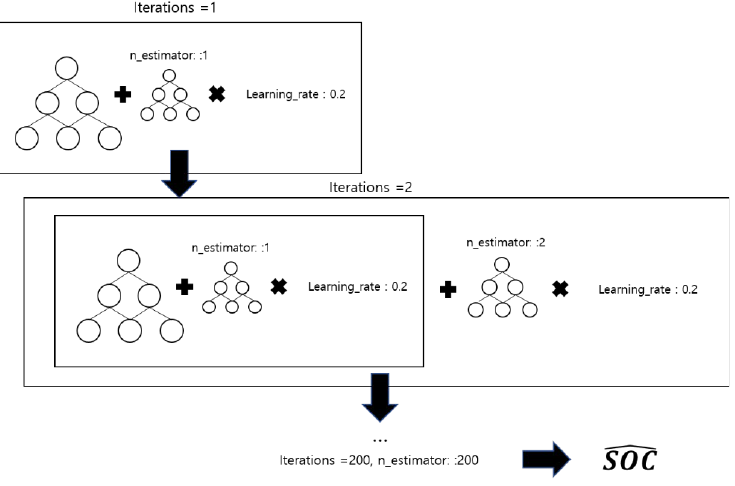
Figure 11. Structure of the GBM for SOC estimation.